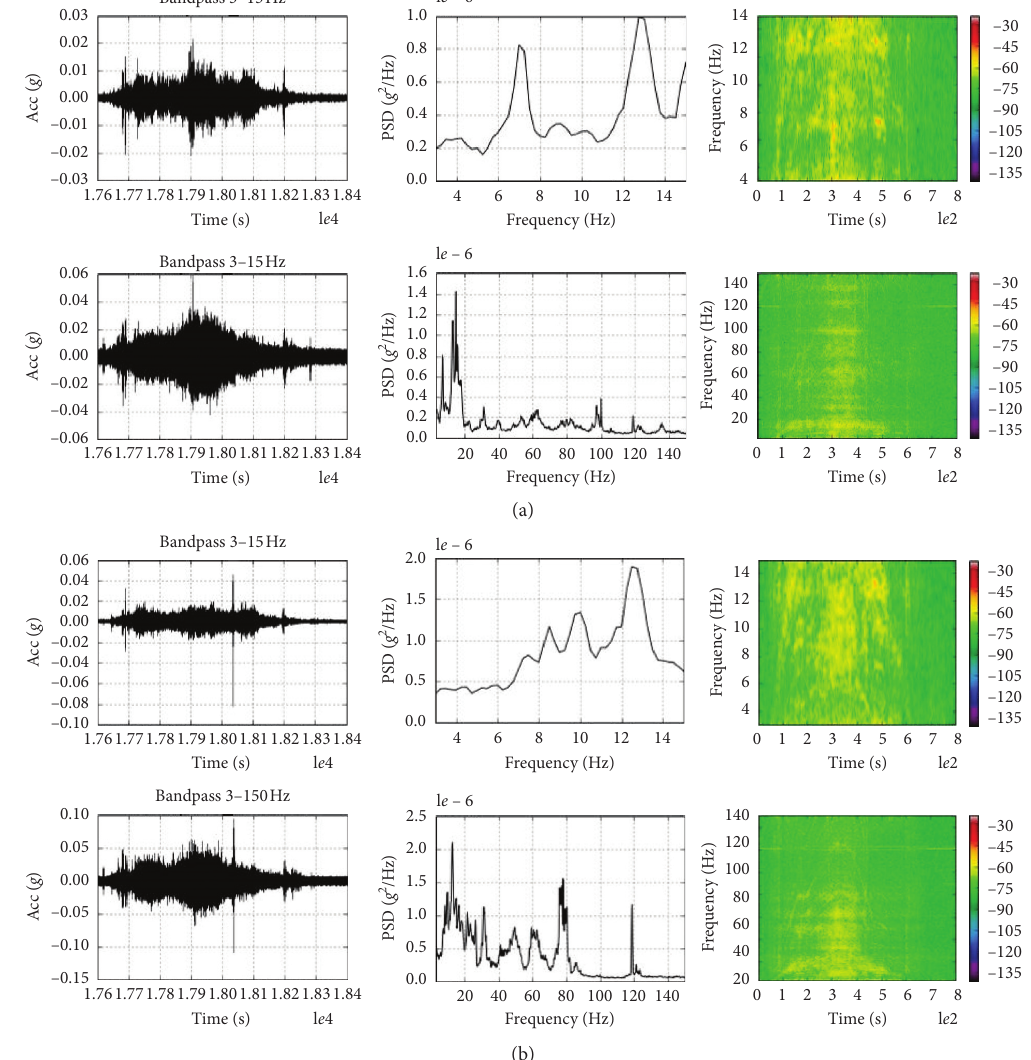
Figure 13: Frequency distribution of unfiltered vibration of CB: (a) lateral vibration; (b) vertical